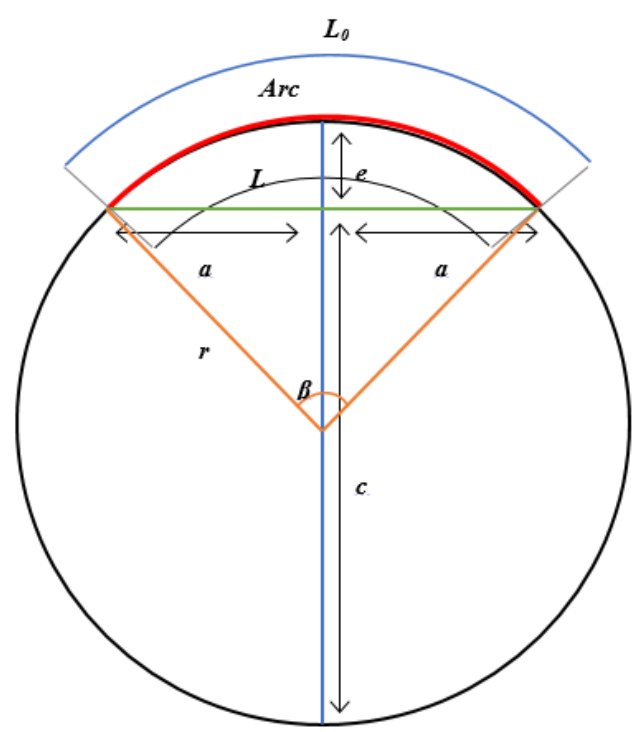
Figure 7. The geometrical analysis of the SBCA.